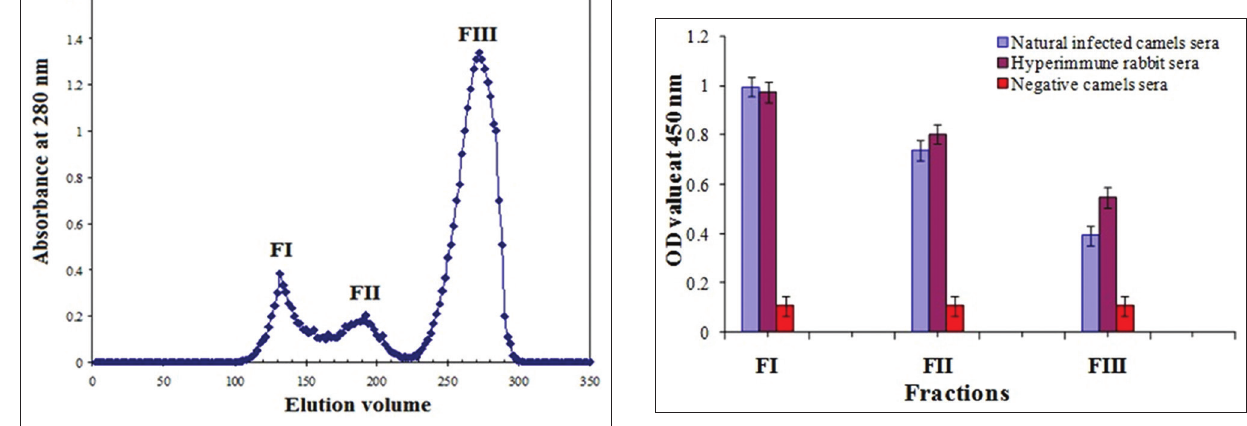
Figure-3: Comparative diagnostic potency of FI, FII and FIII.